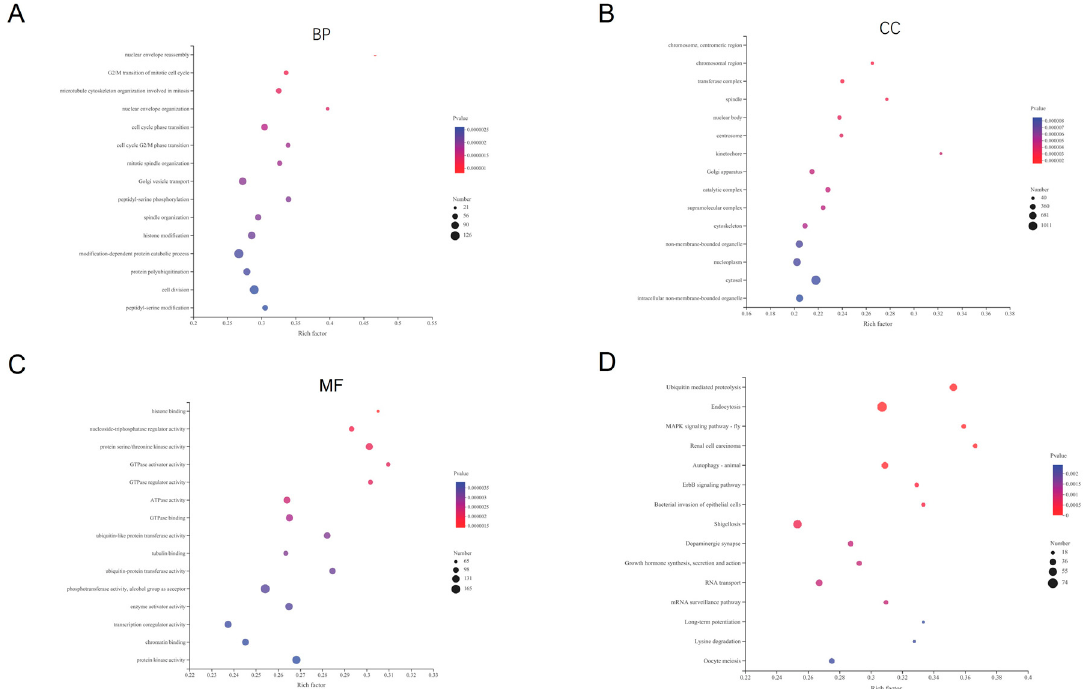
Figure 3. GO analysis and KEGG Pathway analysis. The target genes significantly enrich molecular function (MF), biological process (BP) and cellular component (CC) as shown in ( A – C ). The target genes significantly enrich signal pathways ( D